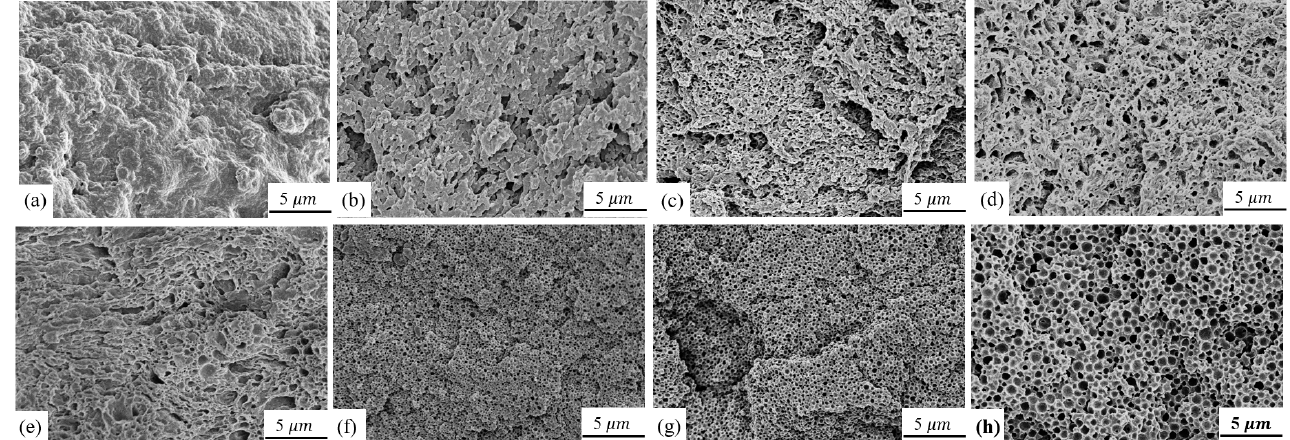
Figure 3. Phase evolution of LC4/LA(70/30) after being statically molten for various durations: ( a ) 0 min, directly out of the TSE; ( b ) 1 min; ( c ) 2 min; ( d ) 3 min; ( e ) 5 min; ( f ) 7 min; ( g ) 10 min; ( h ) 20 min.